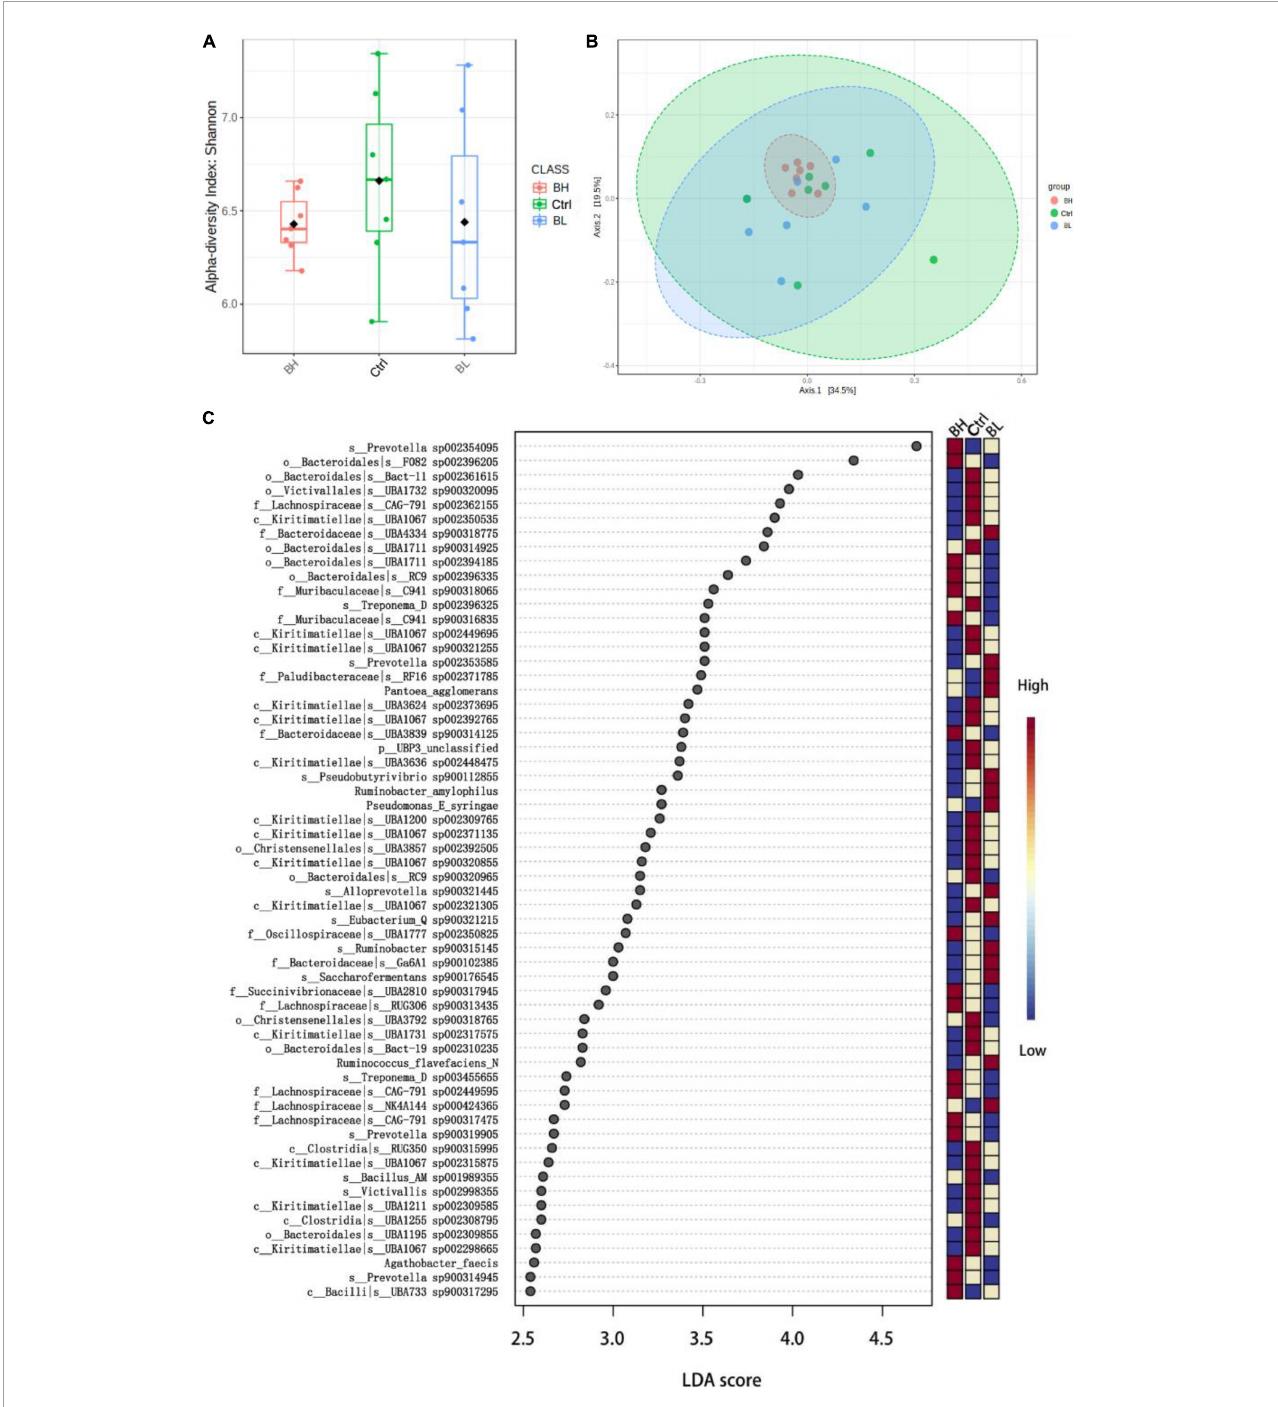
FIGURE1 Effect of biochanin A (BCA) on the structure of rumen microbiome of dairy goats ( n = 7, mean ± SEM). (A) Diversity (Shannon index) analysis of rumen microbiome. (B) Principal component analysis of rumen microbiome. (C) Linear discriminant analysis (LDA) Effect Size analysis of rumen microbial differential flora in genus level. Ctrl, control group; BL, low level BCA group; BH, high level BCA